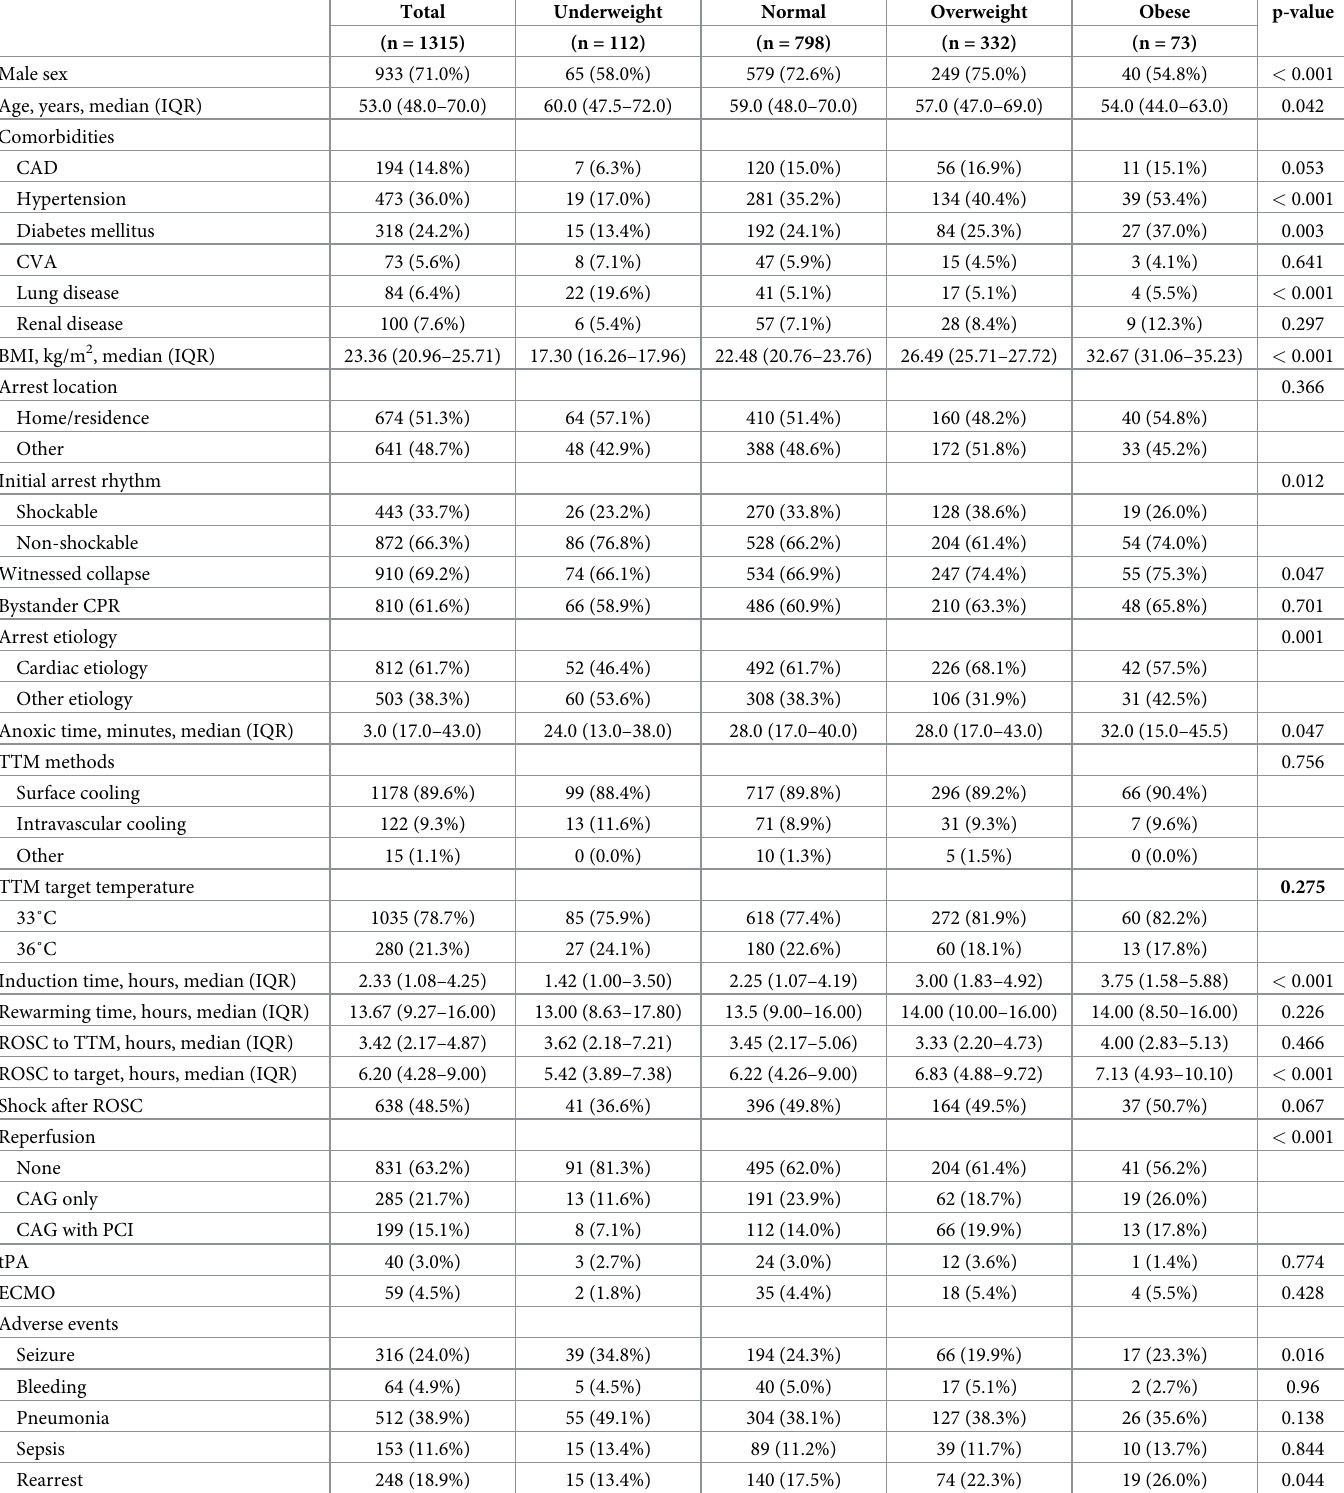
Table 1. Baseline characteristics of patients stratified according to body mass index